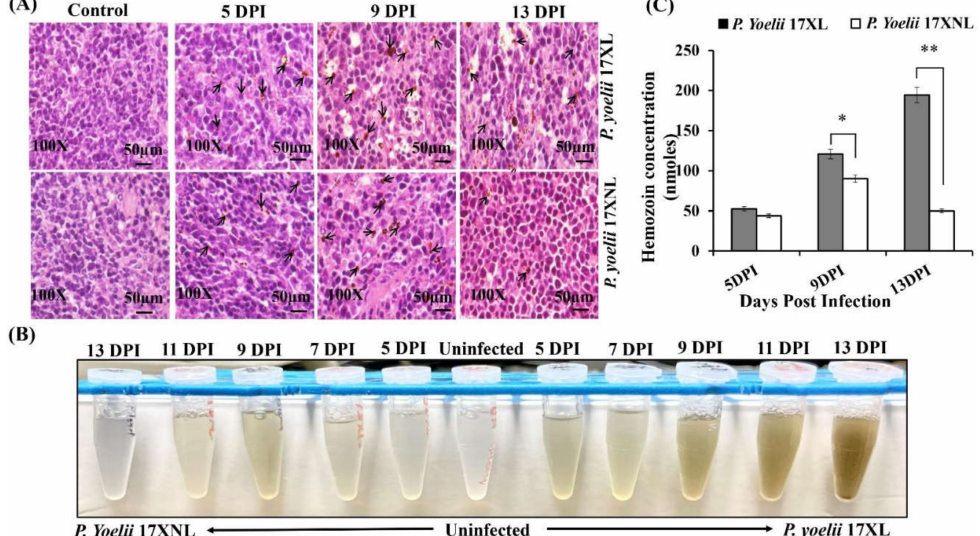
Figure 2. Spleen histopathology and hemozoin quantification during Py 17XL and Py 17XNL infection: Balb/c mice were infected with Py 17XL and Py 17XNL parasites. At indicated time points, mice were sacrificed and spleen tissue was processed for histological examination and hemozoin quantification. ( A ) The presence of hemozoin crystals was monitored in the spleen sections of both P. yoelii 17XL and P. yoelii 17XNL infection at different time points. Black arrows specify the hemozoin content at original magnification of 100X in the spleen of Balb/c mice infected with P. yoelii 17XL and P. yoelii 17XNL at 5th, 9th, and 13th day post-infection. ( B ) Extracted hemozoin from 60–70 mg of spleen tissues obtained after infection at different indicated times. ( C ) Extracted hemozoin was quantified spectrophotometrically in spleen of mice infected with Py 17XL and Py 17XNL and expressed as nmoles/spleen. Unpaired two-tailed Student’s t -test was used to calculate the statistical significance (** p < 0.001, * p <